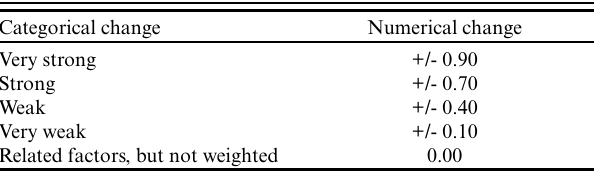
Table 2 . General factors and related factors agreed on in the Table 3 . Redesigned table of categorical and numerical weights.